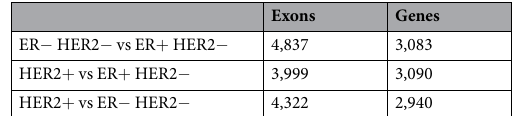
Table 3. Exons and corresponding gene number with alternative usage among